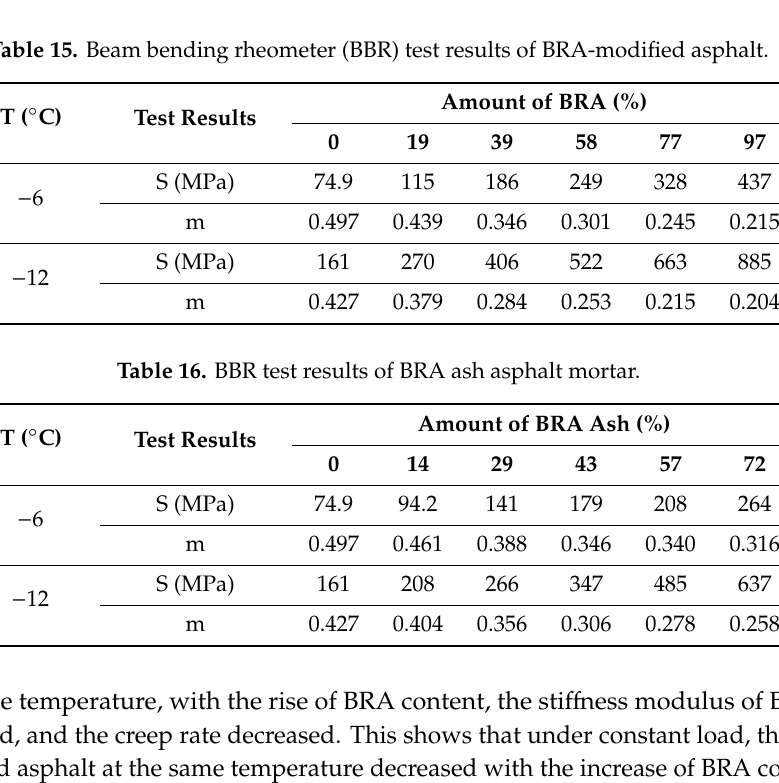
Table 15. Beam bending rheometer (BBR) test results of BRA-modified asphalt.